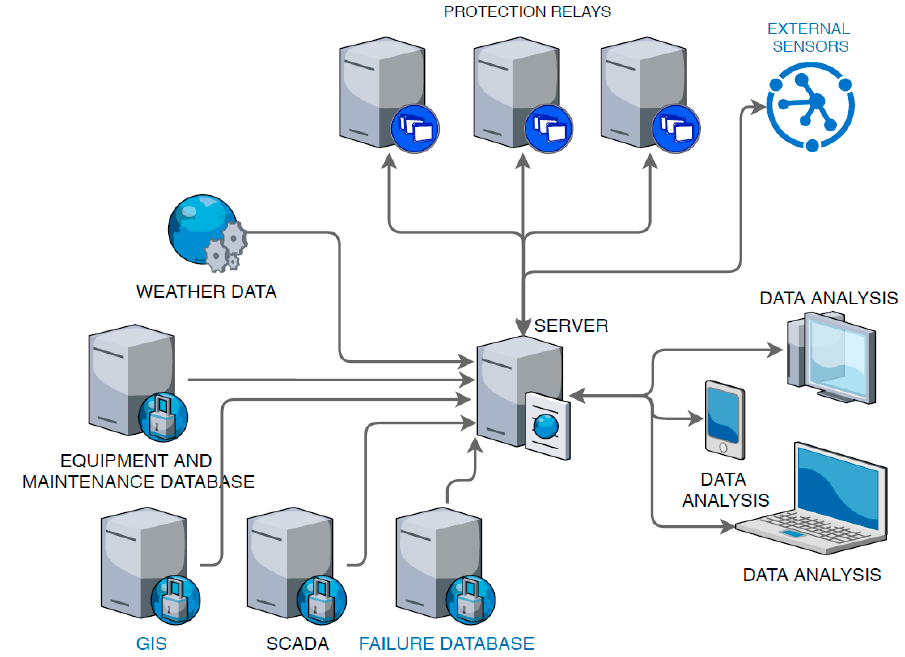
Figure 18. Structure of the proposed system; elements marked with black font are obligatory and elements marked with blue font are